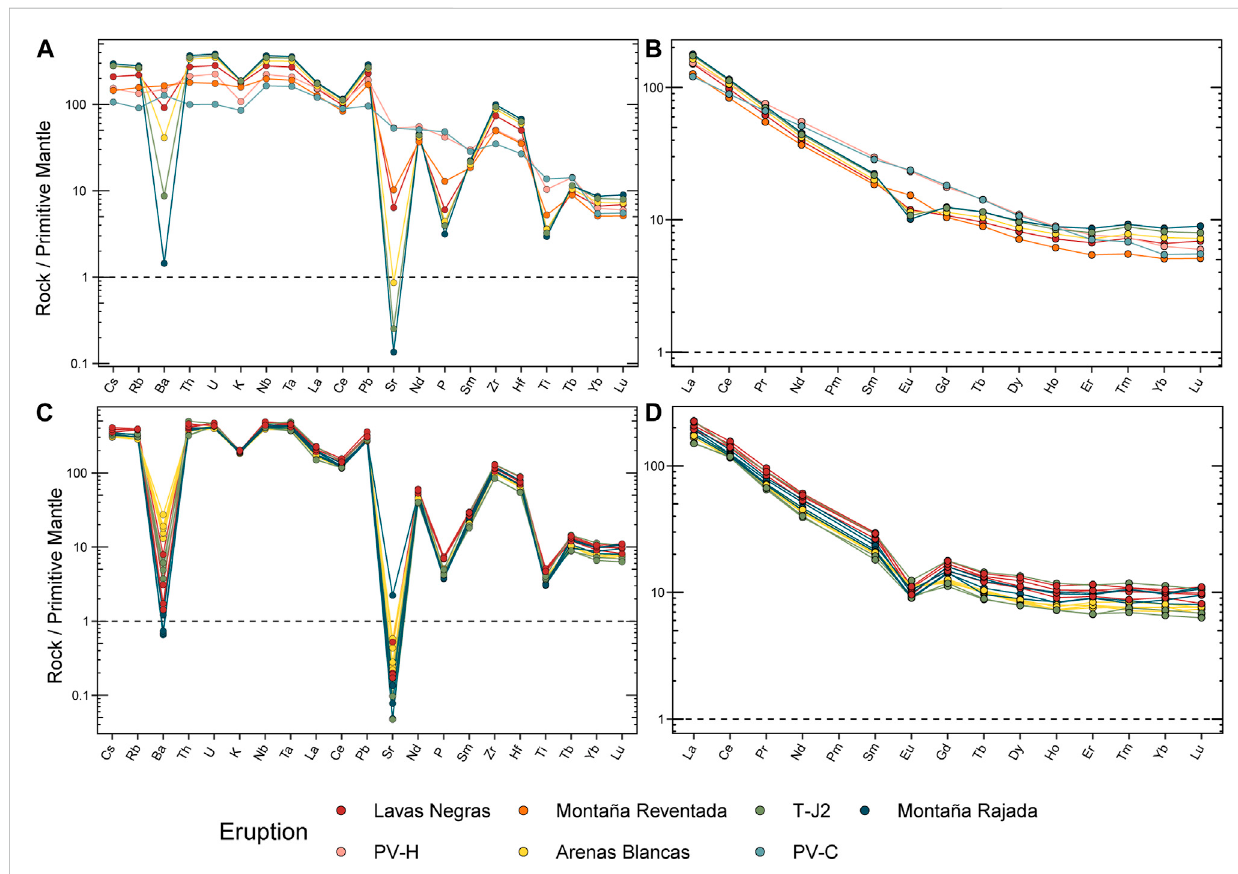
FIGURE 5 Multi-element and REE diagram plots showing trace element data from whole rock (A, B) and glasses (C, D) analyses. Data are normalized to Primitive Mantle (Sun and McDonough